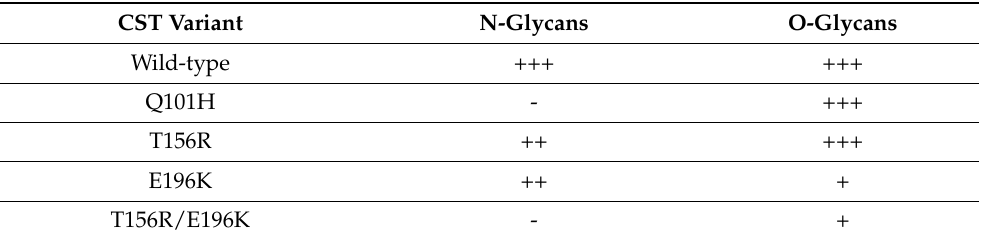
Table 1. The ability of individual CST variants to restore sialylation of N- and O-glycans in the knock-out cells: (-), no rescue; (+), little rescue; (++), moderate rescue; (+++), full rescue. CST Variant N-Glycans O-Glycans Wild-type +++ +++ Q101H - +++ T156R ++ +++ E196K ++ + T156R/E196K -